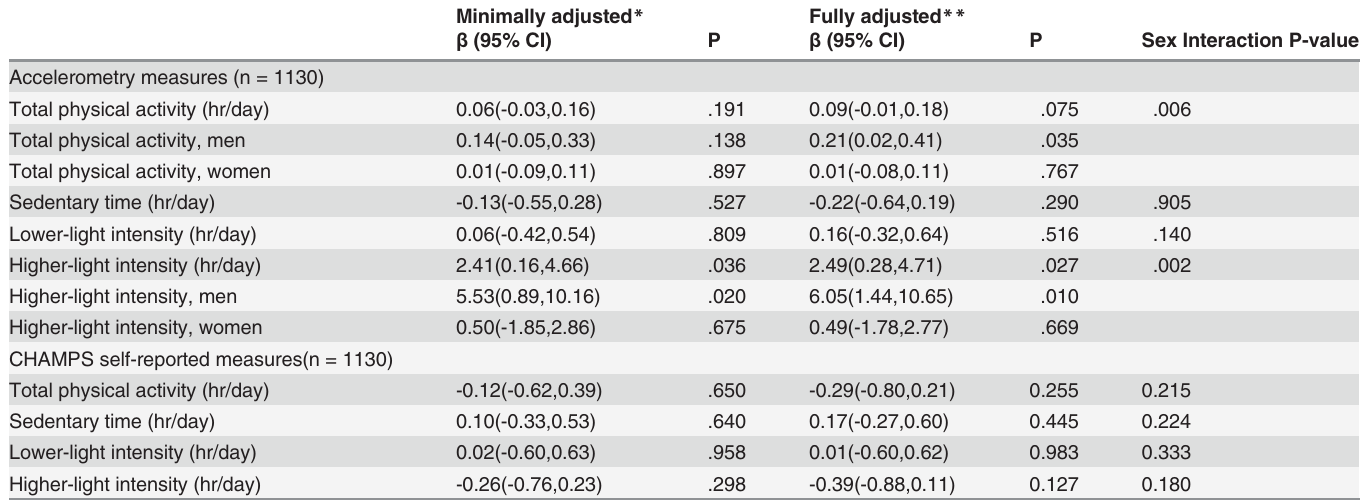
Table 3. Mean differences in grip strength (kg) per unit increase in physical activity and sedentary